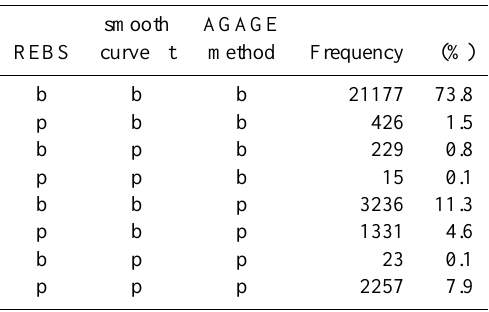
Table 2. Contingency table of the classification of HFC-152a mea- surements at Jungfraujoch from 2000 to 2009 ( n = 15815) with the REBS technique, the smooth curve fit, and the AGAGE method (b=background; p=polluted).